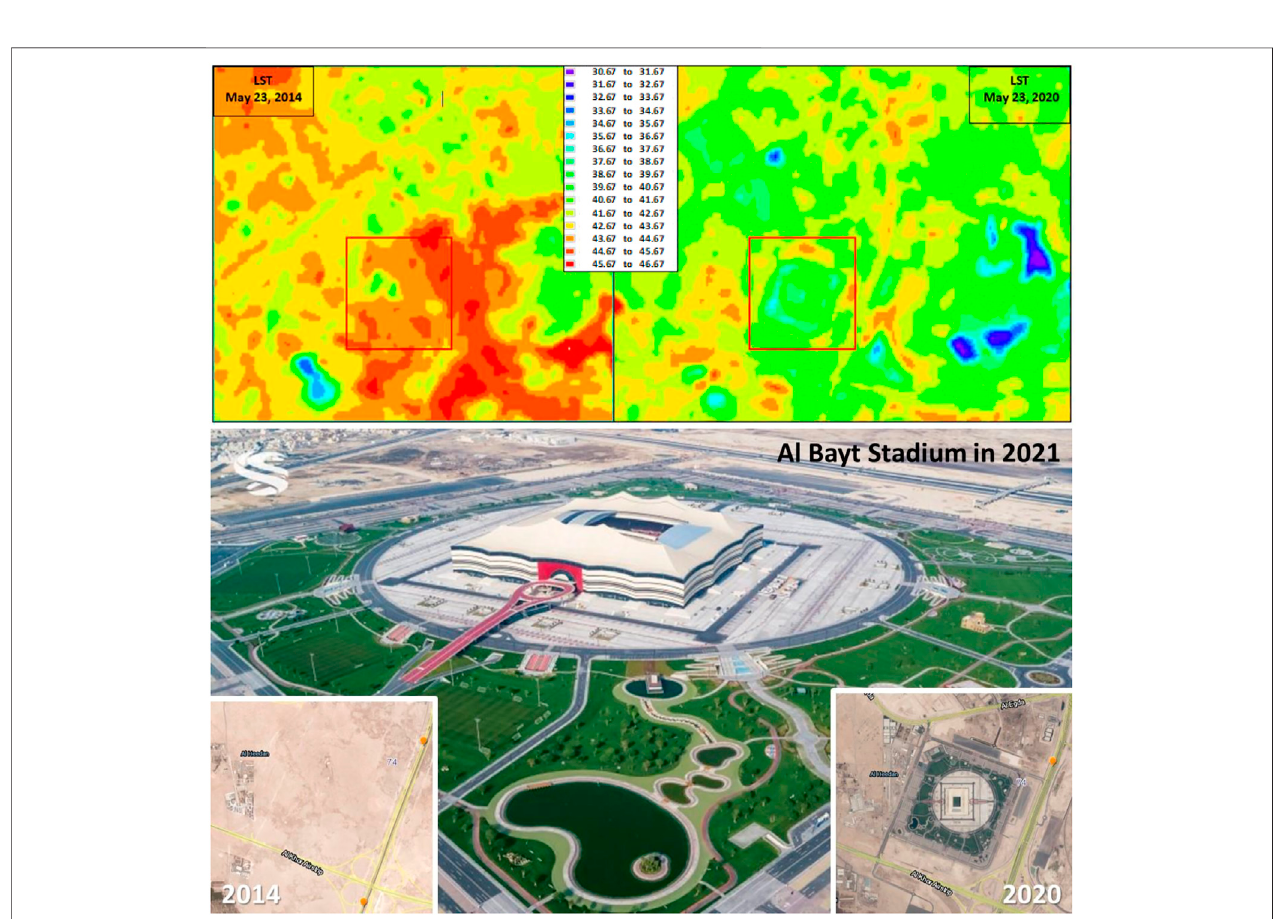
FIGURE 13 | Calculated land surface temperature for May 23, 2014 and May 23, 2020 (using Landsat 8 images) for Al Bayt Stadium. The visual image of the stadium shows the substantial greenery surrounding the stadium.